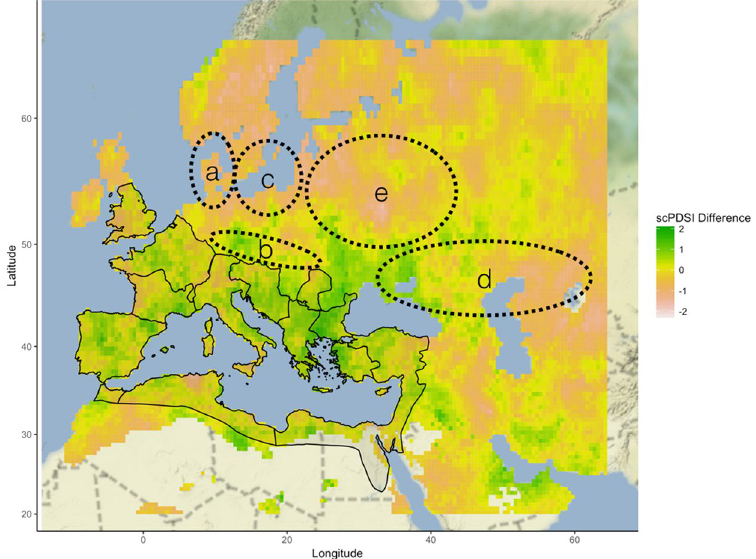
Figure 3. Historical (1900–2014 A.D.) shift in the self-calibrated Palmer Drought Sensitivity Index (scPDSI) from NAO index ranging from 1–2 to an NAO index ranging from 0–1 31, 32 . Areas near the Mediterranean see a shift to wetter conditions, while North Central Europe and the Pontic Steps shift to more arid conditions. Map generated in R (3.3.2) 40 using map tiles by Stamen Design (under CC BY 3.0. Data by OpenStreetMap, under ODbL) and historic scPDSI records 31, 32